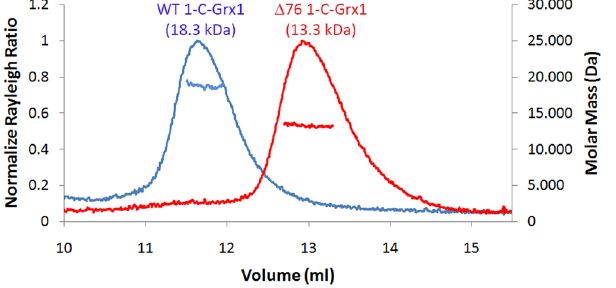
Figure 3. Elution profiles of FL 1CGrx1 (blue) and its Δ 76 mutant (red) examined by SEC-MALS. The horizontal blue and red lines correspond to SEC-MALS calculated masses for full-length- and Δ 76 - 1CGrx1, respectively. The corresponding theoretical masses are 16.1 kDa (full-length) and 12.3 kDa ( Δ 76).